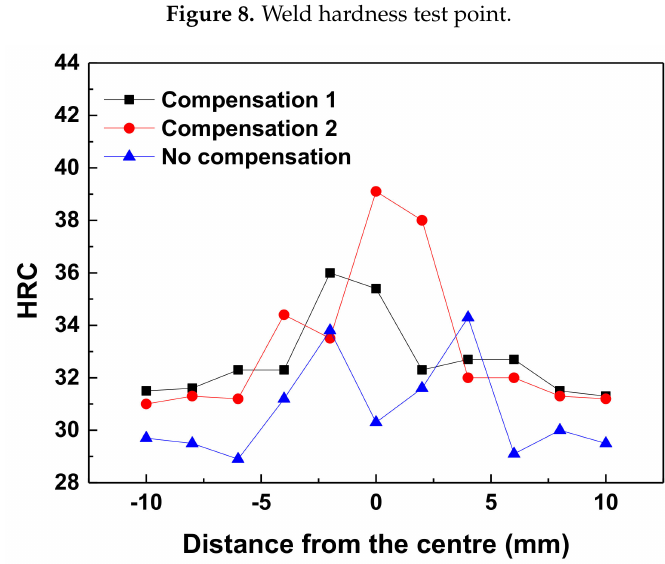
Figure 8. Weld hardness test point.